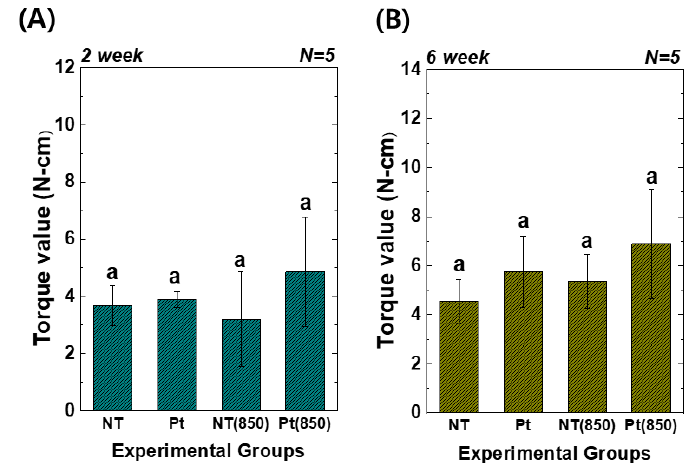
Figure 7. Torque test results of TiO 2 NT- and Pt-TiO 2 NT-treated implants after ( A ) two and ( B ) six weeks of implantation (In each graph, the experimental groups with different letters indicate statistical significance by one-way ANOVA at α = 0.05).